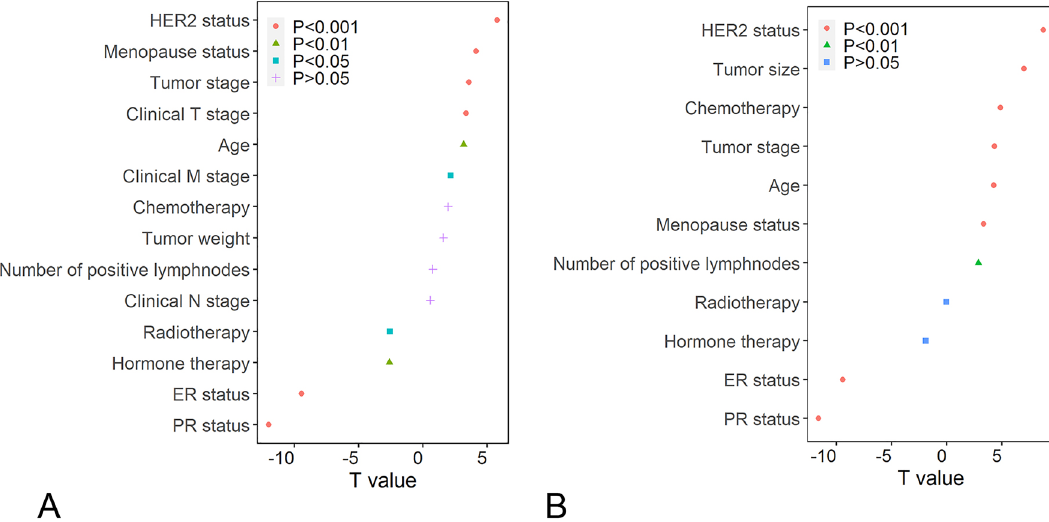
Figure 3. The correlations between the clinical characteristics and the 16-gene score. ( A ) The associations between clinical characteristics and the 16-gene score in the TCGA cohort. ( B ) The associations between clinical characteristics and the 16-gene score in the METABRIC